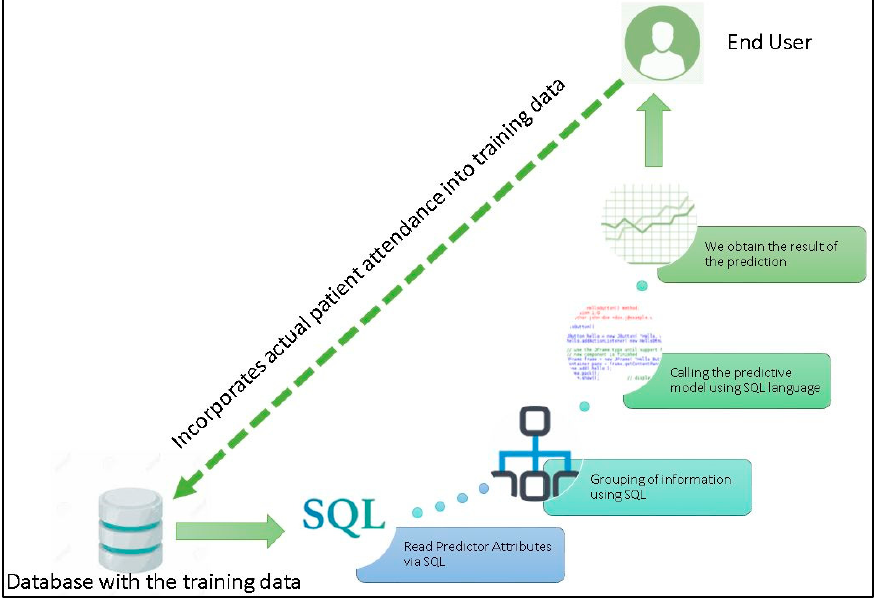
Figure 8. Expert system feedback from training data.